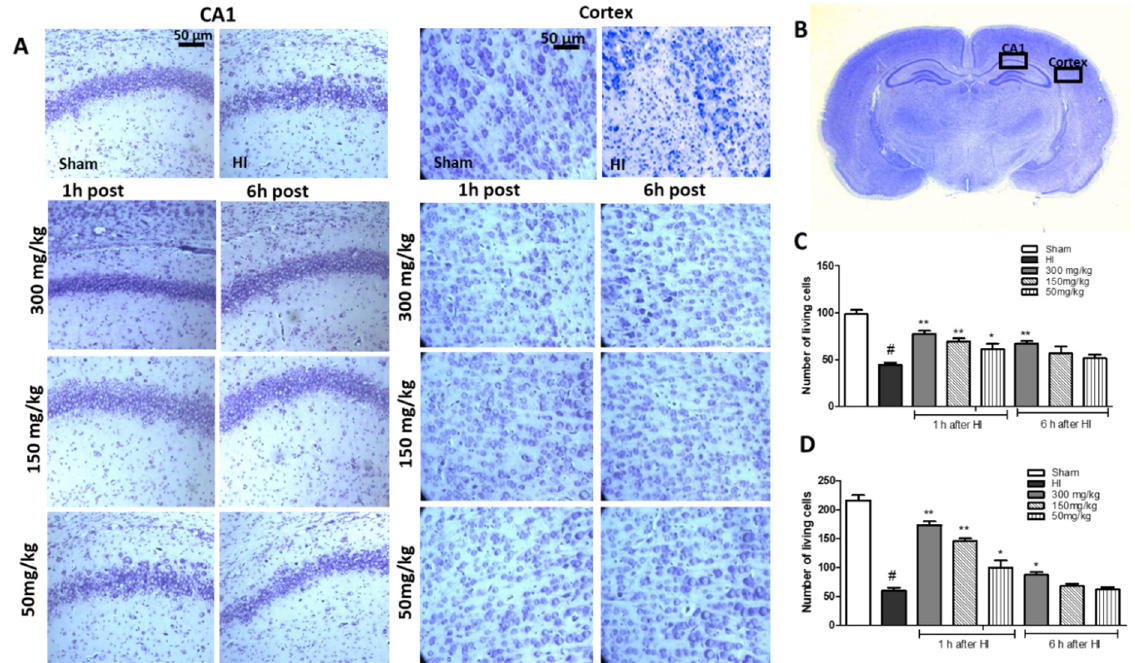
Figure 2. The effect of KYNA application 1 h or 6 h after HI on cell survival was observed in the CA1 region of the hippocampus and the cerebral cortex of the ipsilateral hemisphere 7 days after HI. ( A ) The microphotographs show the ipsilateral hemisphere. Scale bar represents 50 µ m. ( B ) Localization of analyzed brain regions. ( C ) Quantification of surviving neurons in the central part of the CA1 region and ( D ) cortex. The results are presented as the mean ± SEM, n = 6; statistically significant differences: * p < 0.05, ** p < 0.01 compared to the HI group; # p < 0.001 compared to the sham-operated